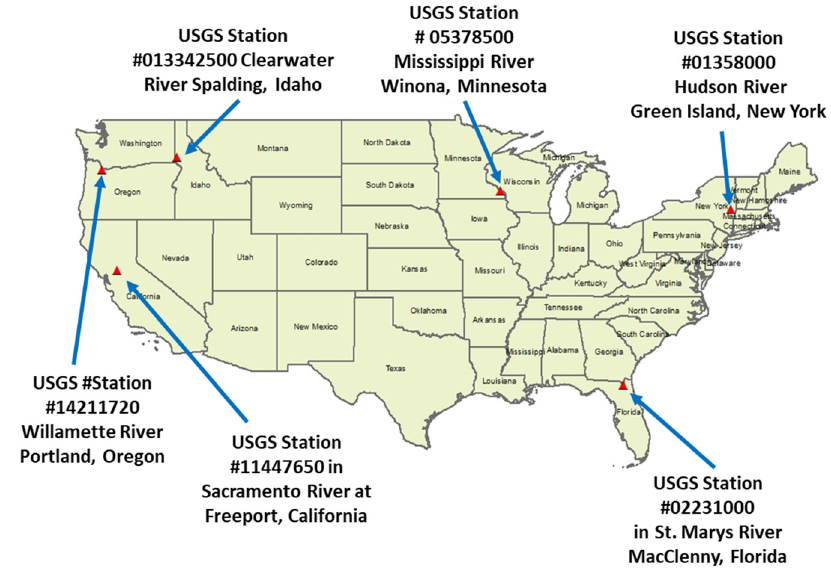
Figure 1. Locations of US Geological Survey gage stations used in this study. Table 1. Sparse measured daily sediment data at Stations #013580000, #02231000, and #013342500. USGS #01358000 USGS #02231000 USGS #013342500 USGS #02231000 Hudson River at Green Island, New